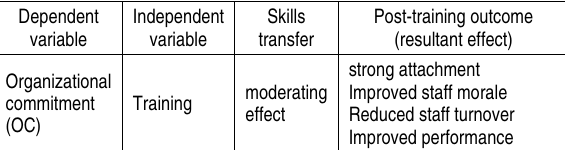
Table 1. Moderating effect of skills development transfer on TVET college staff’s